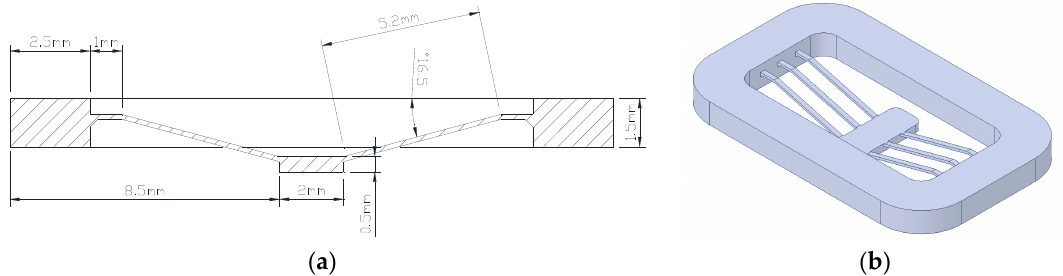
Figure 3. Design of single V-beam structures as mold part: ( a ) Cross section drawing; ( b ) 3D model.